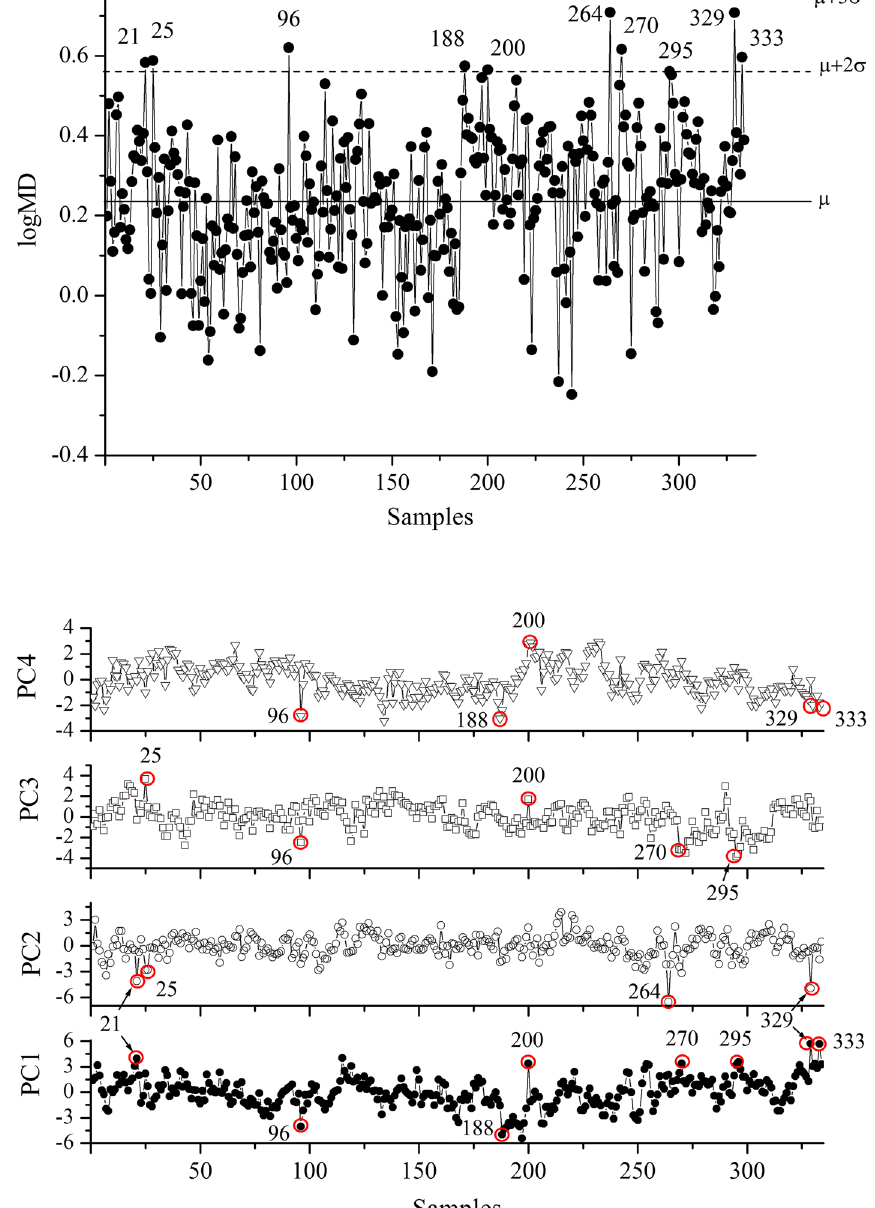
Fig. 2 Chart of logMDs calcu- lated from PCs scores